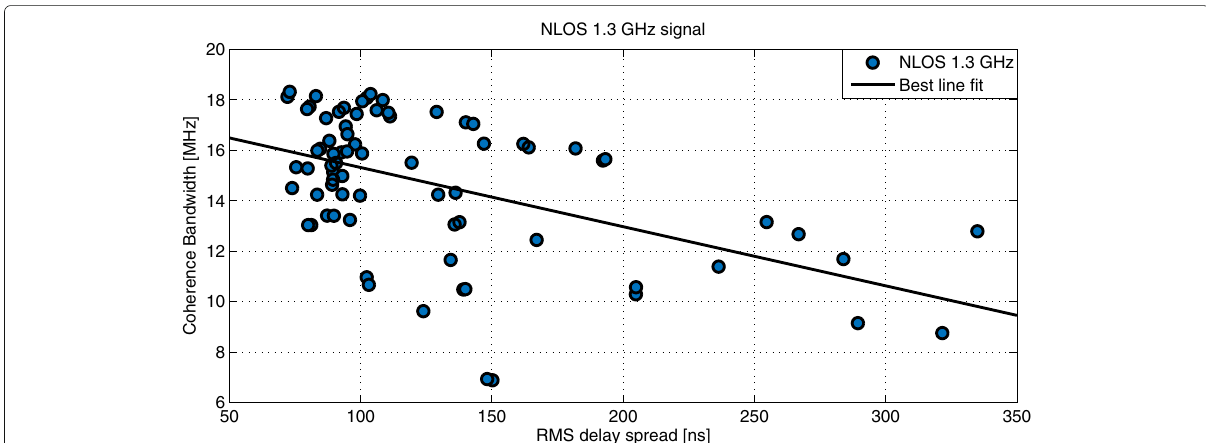
Fig. 12 Coherence bandwidth versus root mean square delay spread for 1.3GHz. Scatter plot of the coherence bandwidth B c ,0.5 against the root mean square delay spread in the case of a transmitted signal with 1.3GHz center frequency in non-line of sight environments